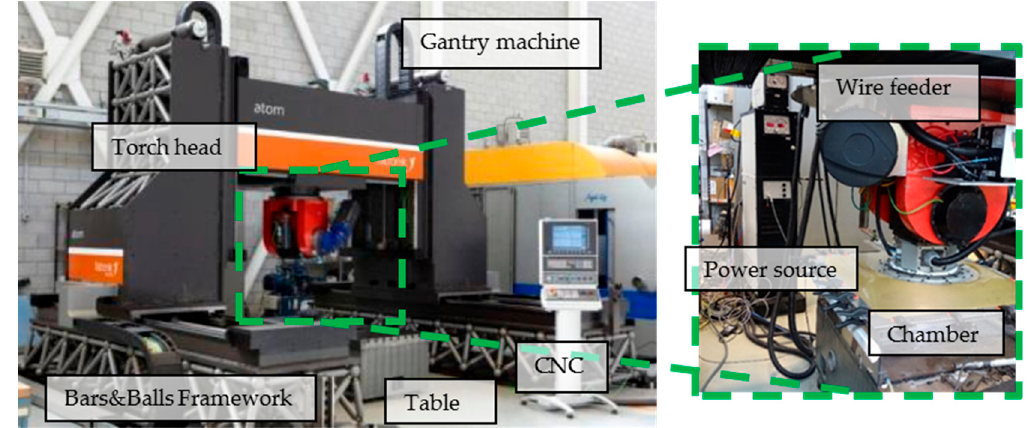
Figure 1. Shaft gantry machine with EWM welding equipment.